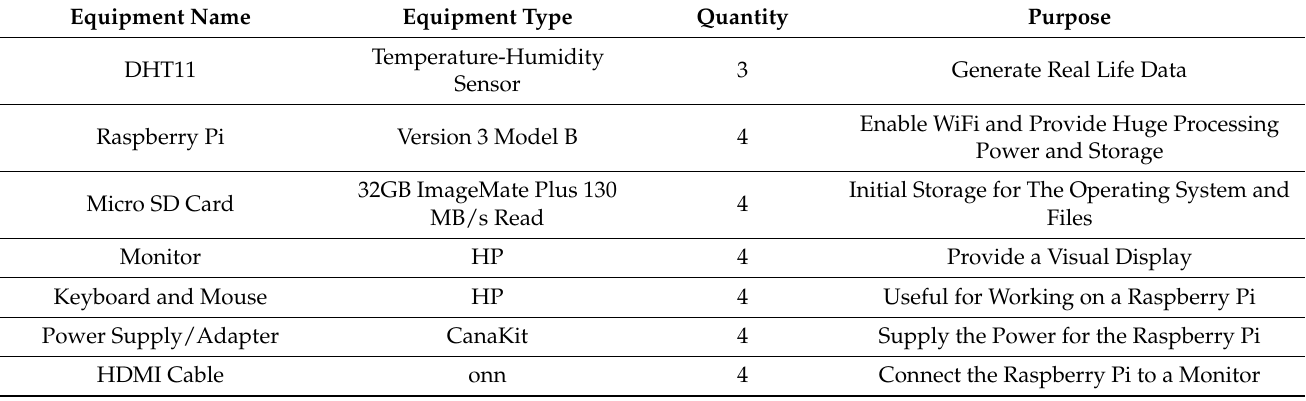
Table 1. Summary of the equipment used in the two